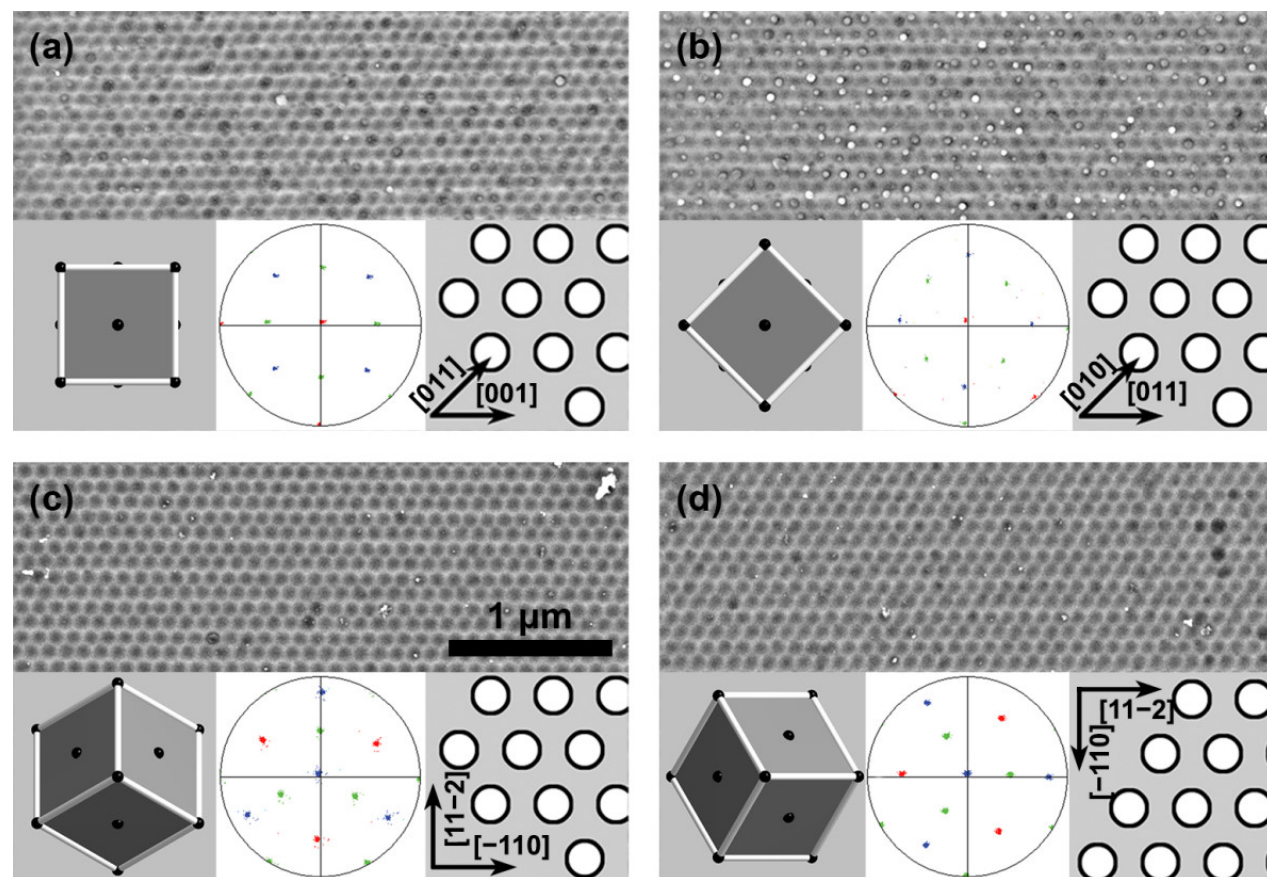
Figure 1. Scanning electron microscopy (SEM) images of the patterned surfaces of Al single crystals: ( a , b ) Al(100) and ( c , d ) Al(111). The scale bar is the same for all images. The insets in each panel illustrate the schemes of Al unit cell orientation (left), electron backscatter diffraction (EBSD) pole figures (middle), and the orientation relationships between the hexagonal array of concaves and the basis vectors of the Al unit cell (right). Reflections in the EBSD pole figures from various crystallographic planes are shown in different colors: {100} (red), {110} (green), and {111} (blue). To perform a quantitative analysis of the porous structures formed during anodization of the patterned substrates, SEM images of the Al surface after the selective dissolution of AAO were color-coded (Figure 2a–c). The color map in Figure 2b visualizes the number of the nearest neighbors around the considered pore. Pore positions with hexagonal coordination are marked in green, whereas pores near defects possessing five and seven nearest neighbors are colored red and blue, respectively. As shown, the patterned area does not have any defects, whereas the Al replica of the self-ordered AAO consists of domains— areas with a hexagonal ordering—and has numerous pore positions with five and seven nearest neighbors at the domain boundaries. For all pores with hexagonal coordination, the azimuthal orientation of the hexagon formed by their nearest neighbors was calculated (Figure 2c). The azimuthal orientation is constant within the patterned area, whereas domains are misaligned from one other in the self-ordered area. A low-magnification SEM image of the Al surface after the selective dissolution of AAO formed on the FIB-patterned surface is shown in Supplementary Materials, Figure S1. The corresponding color maps illustrate the prevalent hexagonal arrangement of the pores and narrow distribution of the target azimuthal orientations (Supplementary Materials, Figure